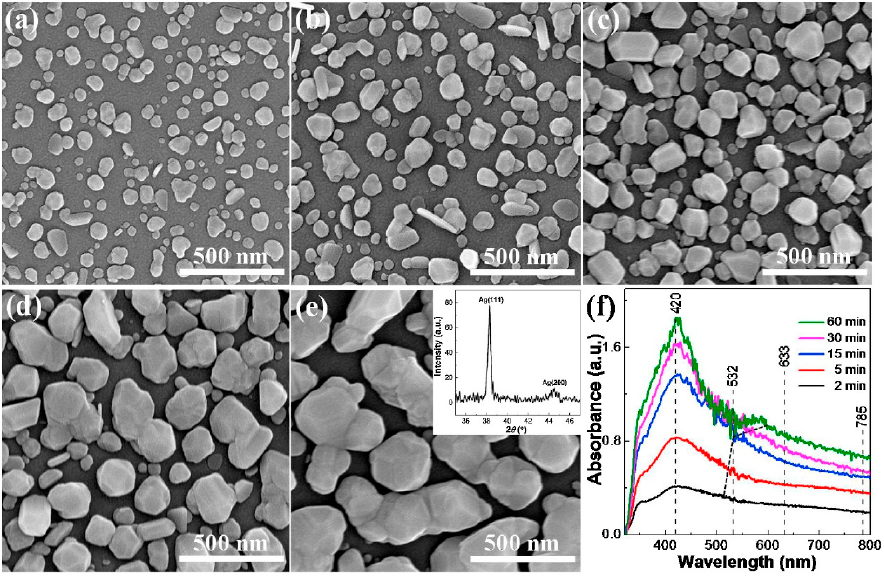
Figure 5. The SEM images of Ag NPs synthesized on TiO 2 film under different UV irradiation for ( a ) 2, ( b ) 5, ( c ) 15, ( d ) 30, and ( e ) 60 min. ( f ) The corresponding in situ real-time UV–vis absorbance spectra of 5( a – e ), respectively [109].